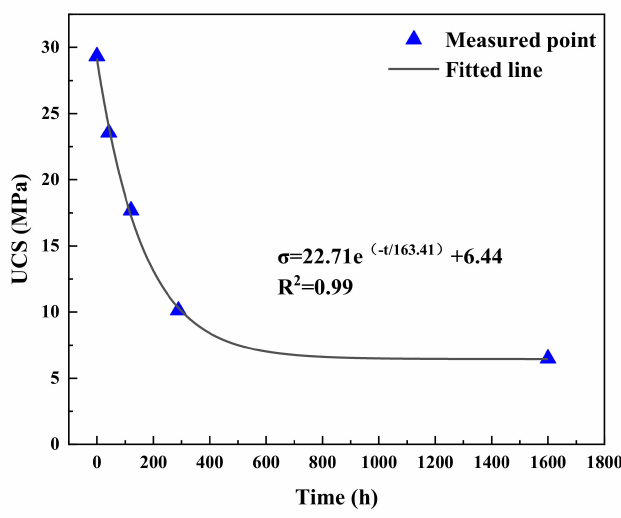
Figure 10. Fitting curve of the relationship between UCS and